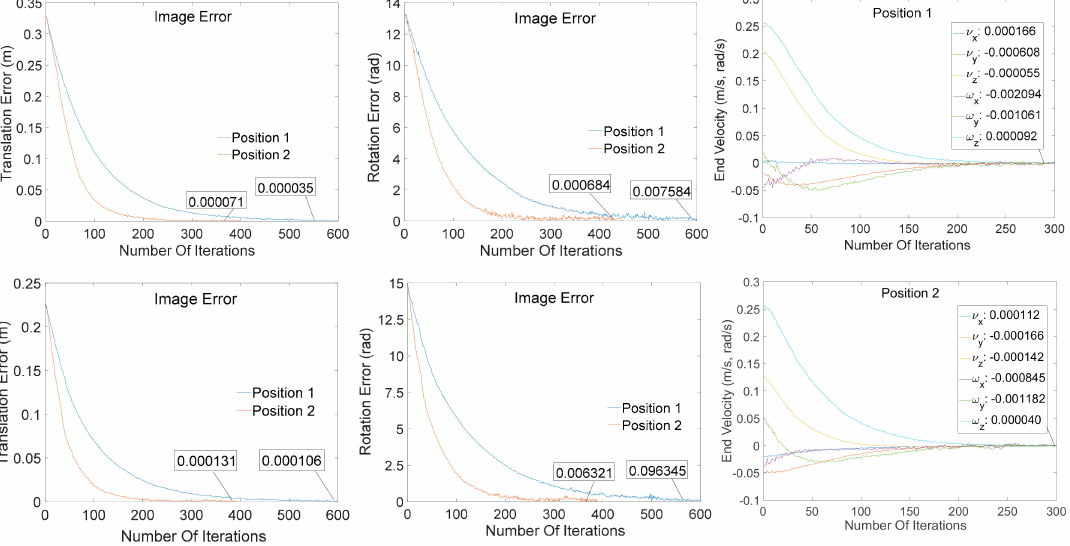
Figure 14. The index data of the robot arms at di ff erent positions during the servo